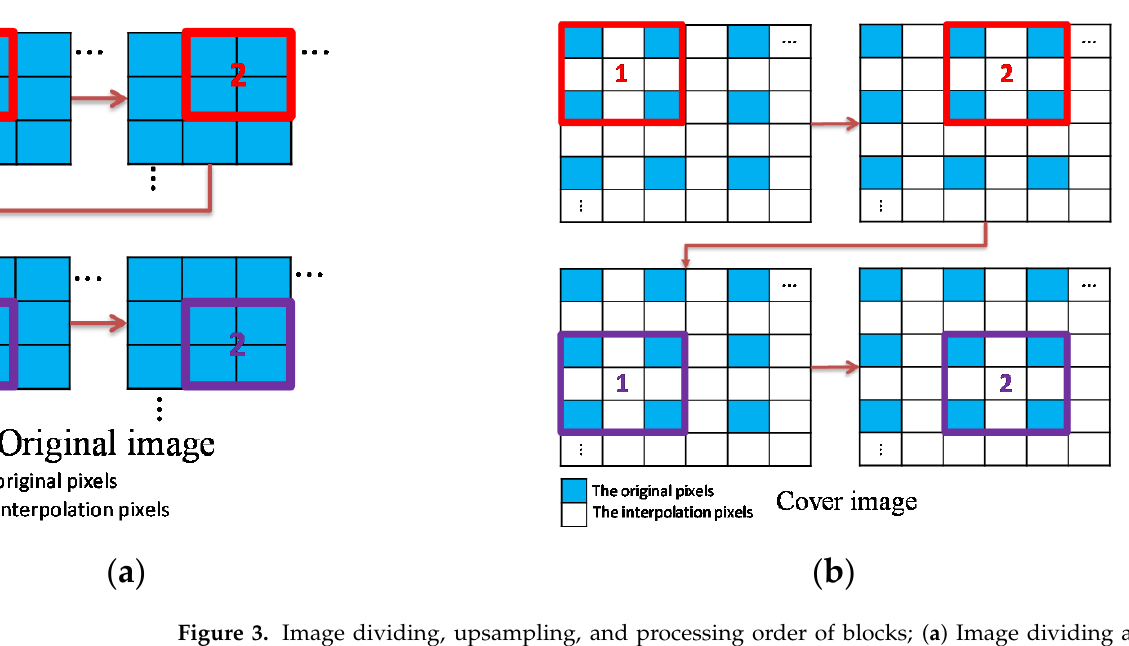
Figure 3. Image dividing, upsampling, and processing order of blocks; ( a ) Image dividing and processing order; ( b ) Processing order of upsampled image blocks.